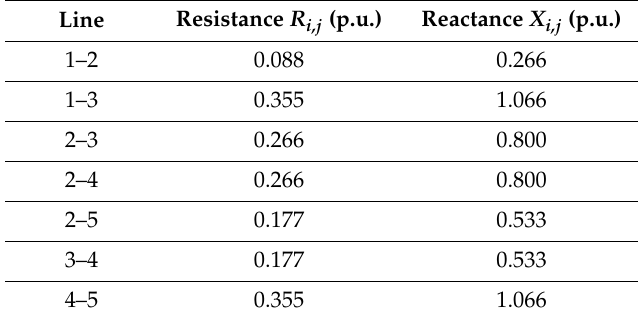
Figure 4. Modified IEEE 5 bus test system. Table 1. Lines data.